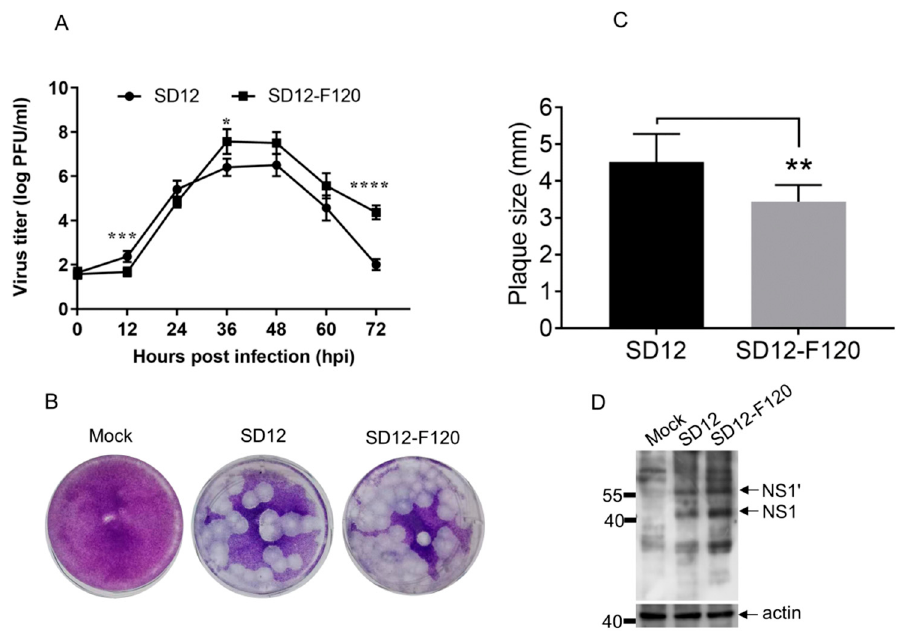
Figure 1. Replication phenotypes of SD12-F120 and SD12 in BHK-21 cells. ( A ) BHK-21 cells were inoculated with SD12-F120 or SD12 at an MOI of 0.01 and the supernatants were collected at the indicated time intervals. JEV titers in the supernatants were measured by plaque assay. (B and C) BHK-21 cells were mock-infected or infected with SD12-F120 or SD12 for analysis of plaque morphology. The plaques were stained with crystal violet at 5 dpi ( B ). The sizes of plaques were measured and plotted ( C ). ( D ) BHK-21 cells were mock-infected or infected with SD12-F120 or SD12 and harvested for western blot analysis of NS1 and NS1 ʹ expression with antibodies specific to NS1 and NS1’. Data are presented as mean ± SD from three independent experiments. * p < 0.05; ** p < 0.01; *** p < 0.001; **** p < 0.0001 tested by Student’s t -test.